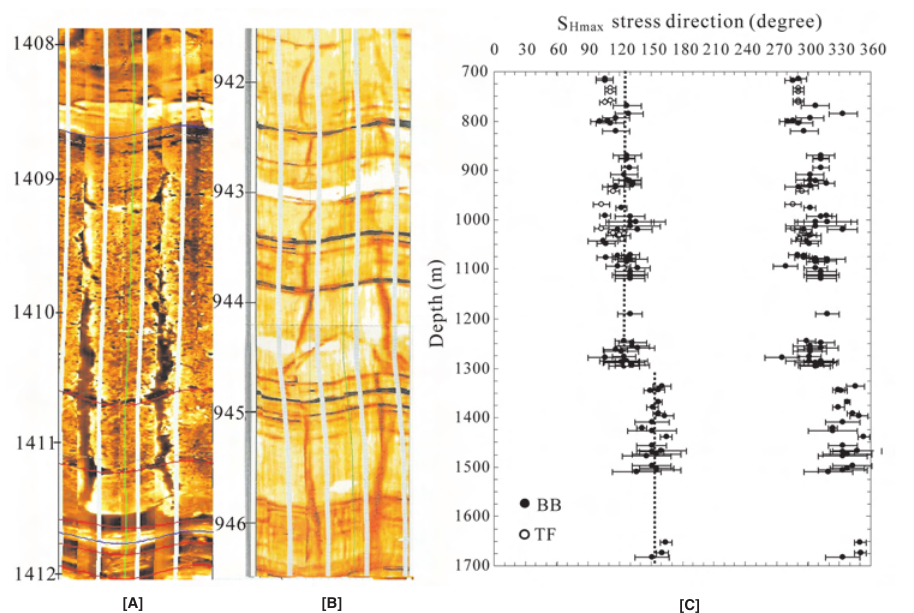
Figure 4. [A] Borehole breakouts as dark bands in opposite sides of the wellbore wall in FMI image logs of Hole A between 1409 m and 1411 m, and [B] drilling-induced tensile fractures in the Hole B at 941–947 m. [C] The plot of azimuth of S hmzx determined from breakouts (BO) and tensile fractures (TF) in the TCDP wells. Width of bar shows an opening angle of BO and TF with dark and open circles, respectively, as mid-point. Dotted lines are average of mid- points between sections of 700–1300 m and 1300–1700